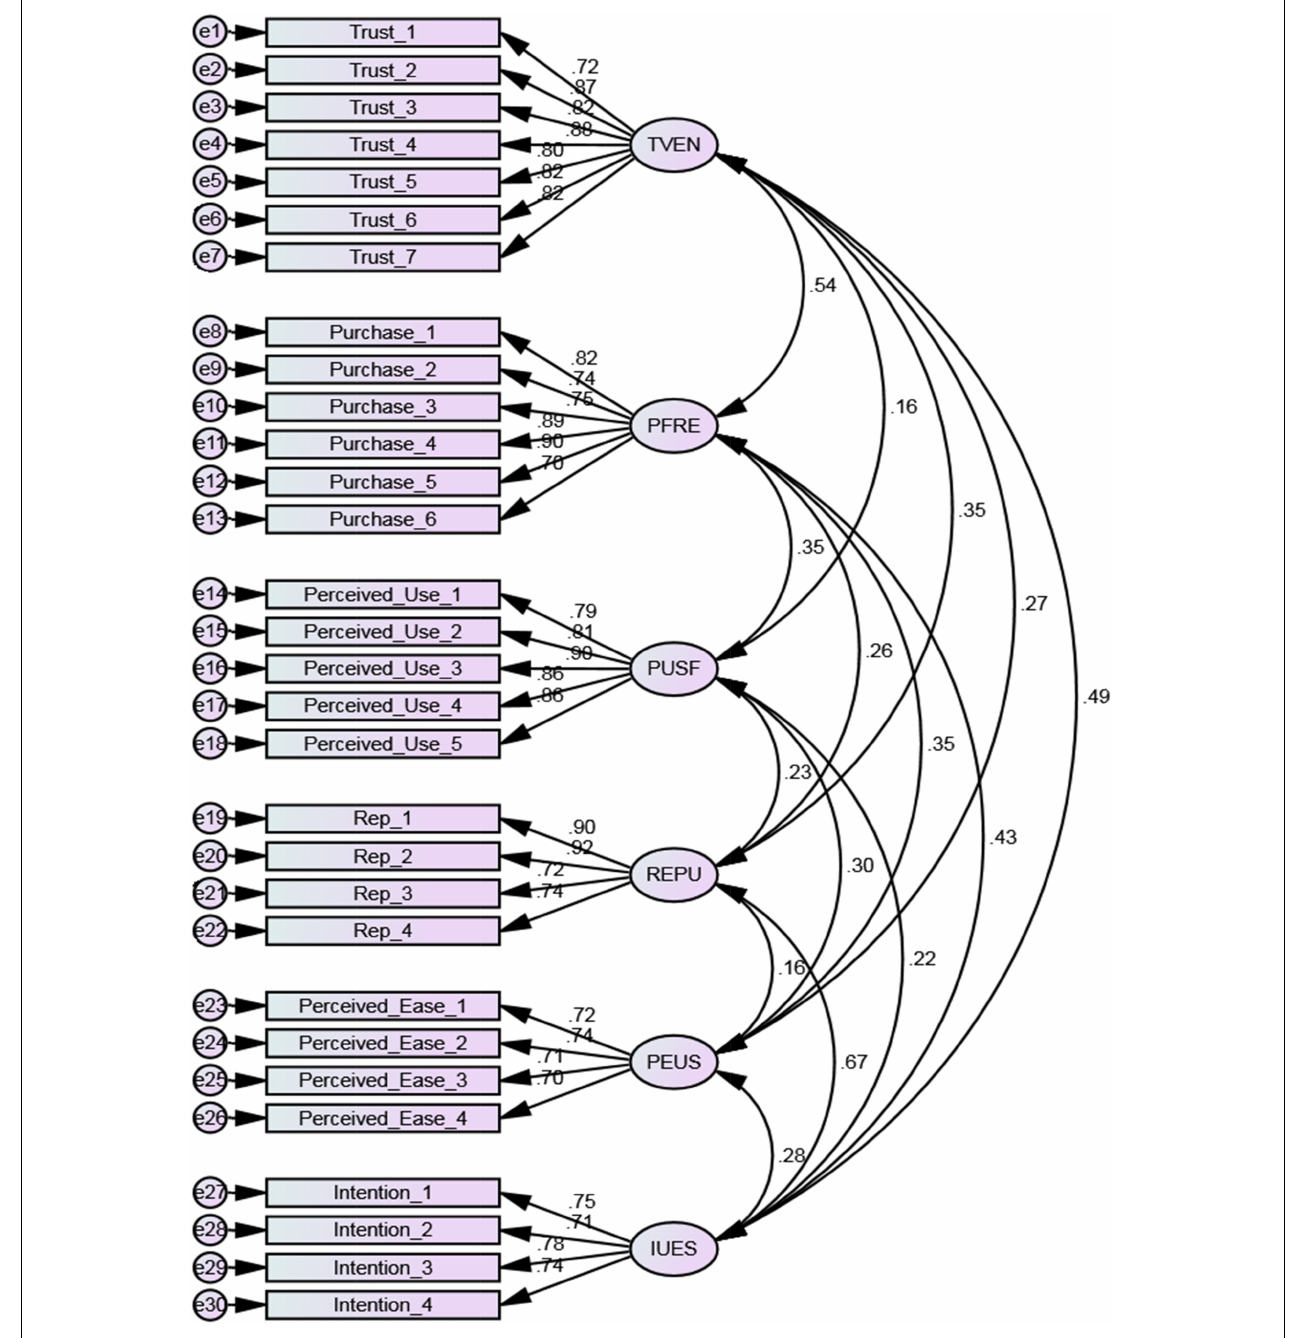
FIGURE 2 | Confirmatory factor analysis is a type of statistical analysis that is used to represent a measurement model. Source: Authors’